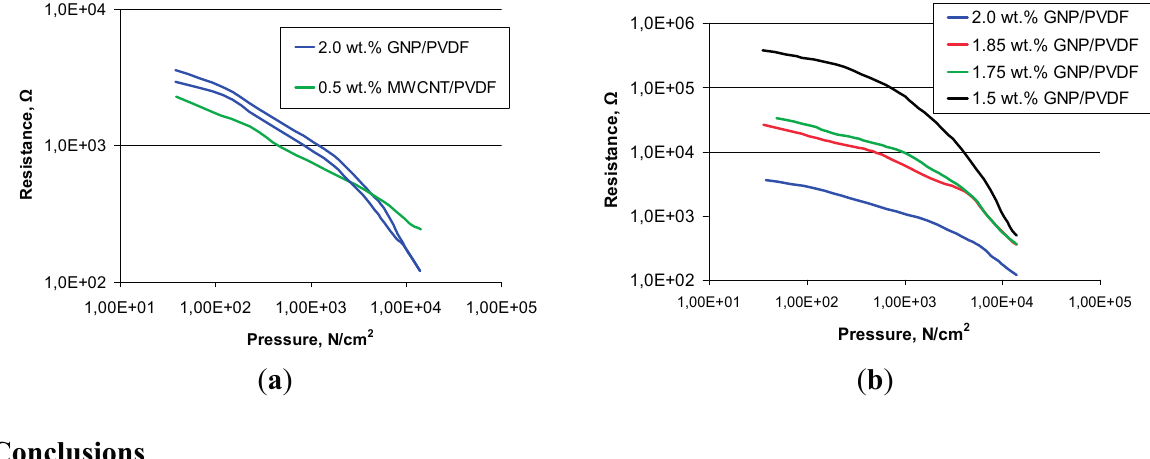
Figure 4. Characteristics of the pressure sensors made with the PVDF resin pastes: ( a ) MWCNT and GNP pressure-sensitive layers with 150 k Ω /sq sheet resistivity, ( b ) GNP pressure-sensitive layer with sheet resistances from 150 k Ω /sq to 5 M Ω